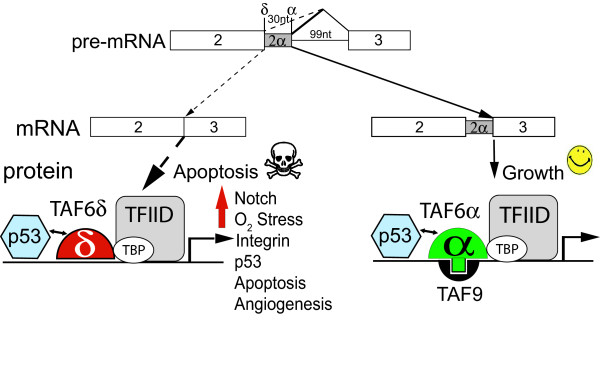
A model for the TAF6δ pathway. A hypothetical model coupling changes in gene expression to cell death via the TAF6δ pathway of apoptosis. See Discussion for details.